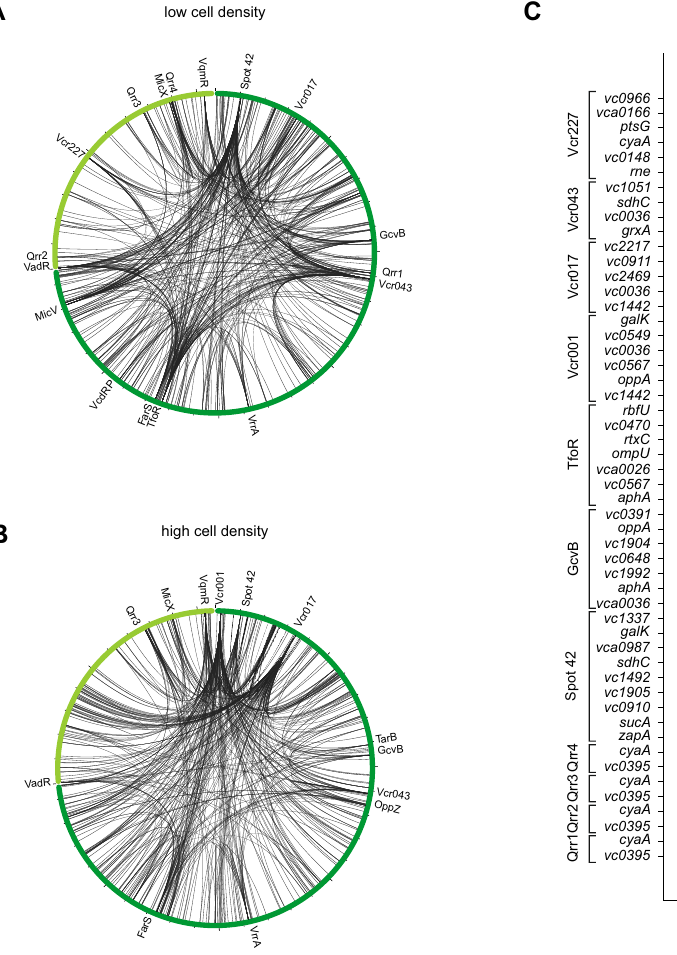
interactions predicted by RIL-seq. Translational GFP reporter fusions were co- transformed with a constitutive sRNA expression plasmid or an empty control plasmidin E.coli Top10cells.GFPproductionwasmeasuredand fl uorophorelevels from the control strains were set to 1. Bars show mean of independent biological replicates ± propagated SD, n =3. Data belonging to a common regulating sRNA are presented in the same color. Source data underlying panel C is provided as a Source Data fi